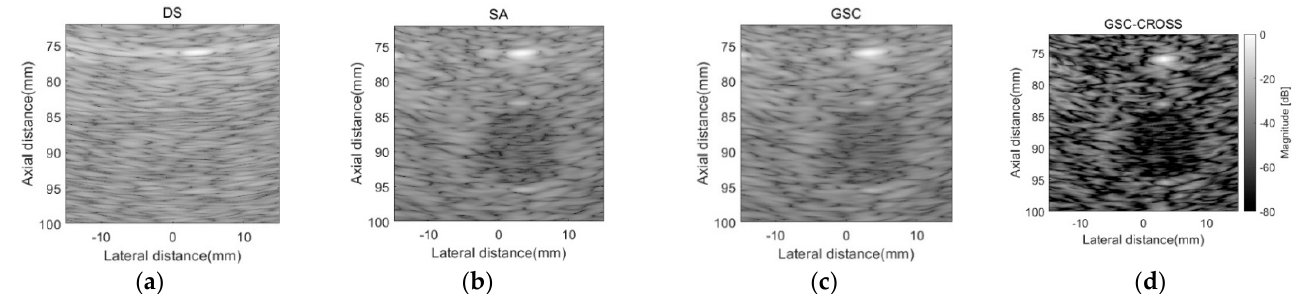
Figure 7. images of actual echo data with different algorithms. ( a ) DS; ( b ) SA; ( c ) GSC (L = 16, Δ = 20); ( d ) GSC-CROSS (L = 16, Δ = 20). The dynamic range of image is 80 dB.